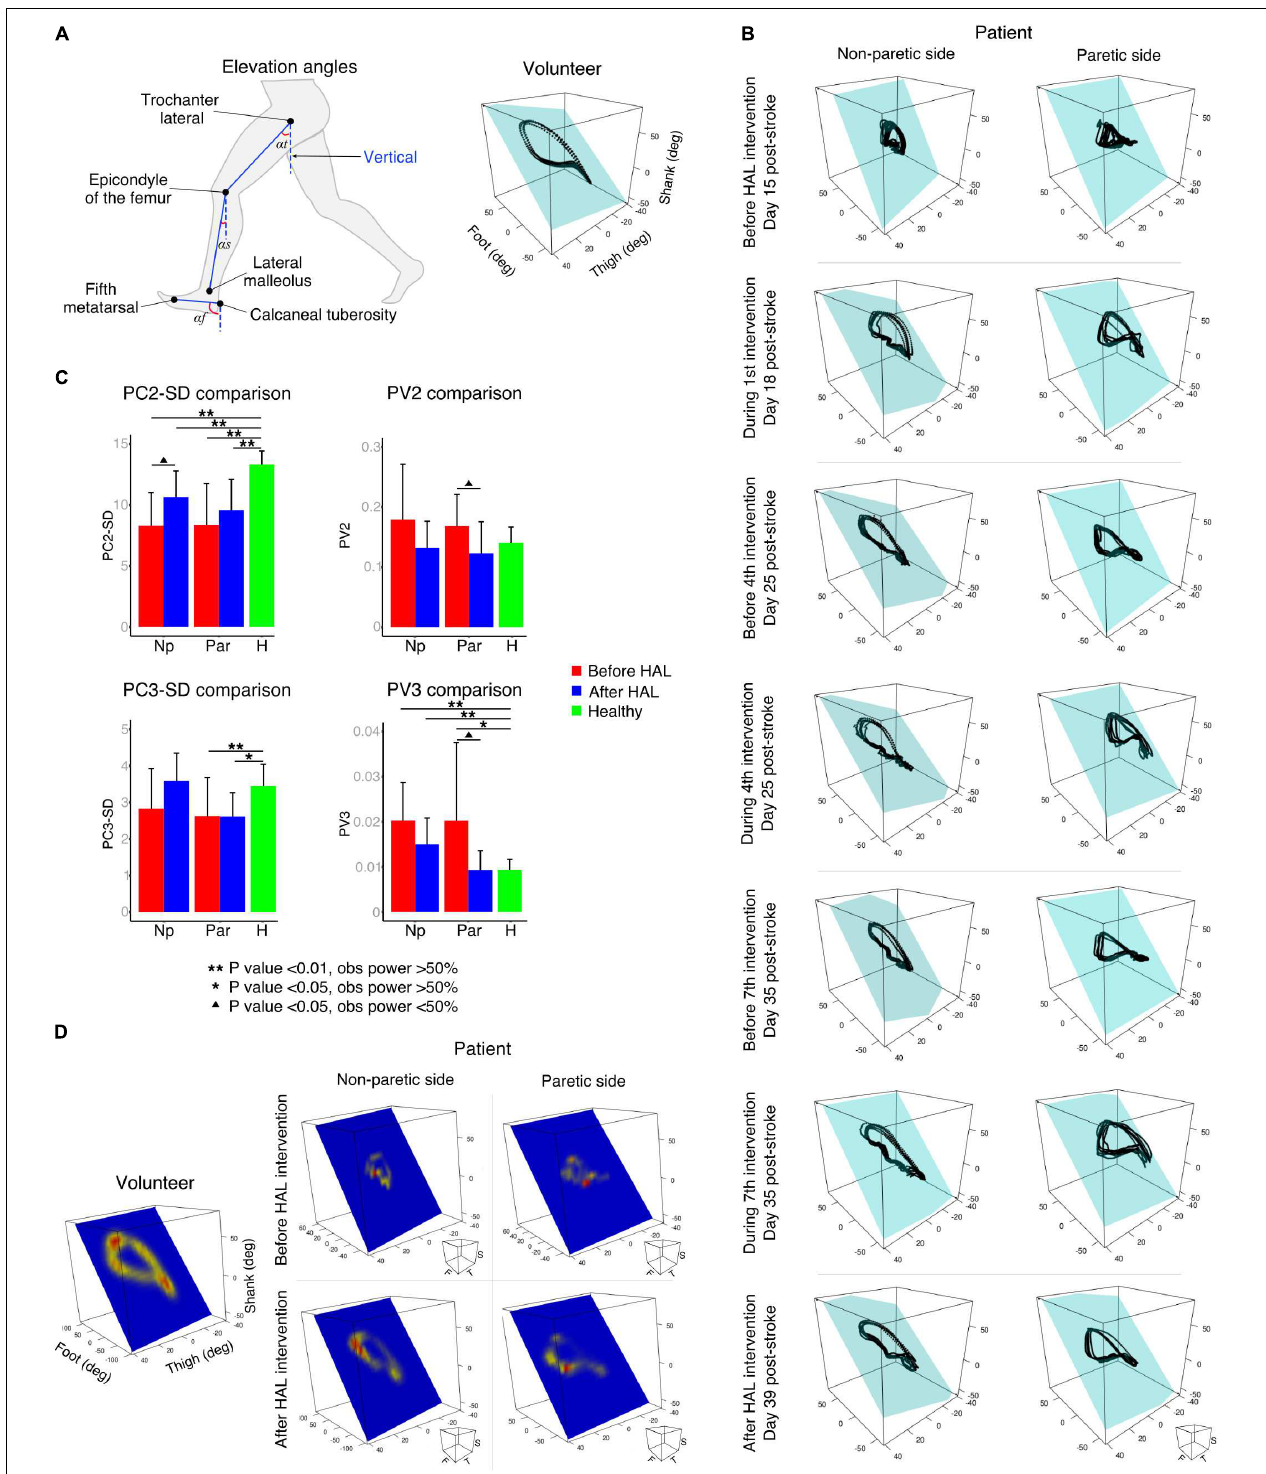
FIGURE 2 | Planar covariation of elevation angles. (A) Left: thigh, shank, and foot limb segments used to calculate the elevation angles. Right: planar covariation sample from one healthy volunteer leg. (B) Planar covariation sample from one patient paretic and non-paretic leg before, during and after HAL intervention. Each dotted line corresponds to different strides of the same limb (C) PCA comparisons using second (PC2) and third (PC3) components. Comparisons of the actual data were done with the standard deviation (SD). The proportional variance of both components was also analyzed (PV2 and PV3). (D) Heat maps were used to plot the deviation from the plane for each participant. Sample from one volunteer leg and one patient paretic and non-paretic leg before and after HAL are shown.